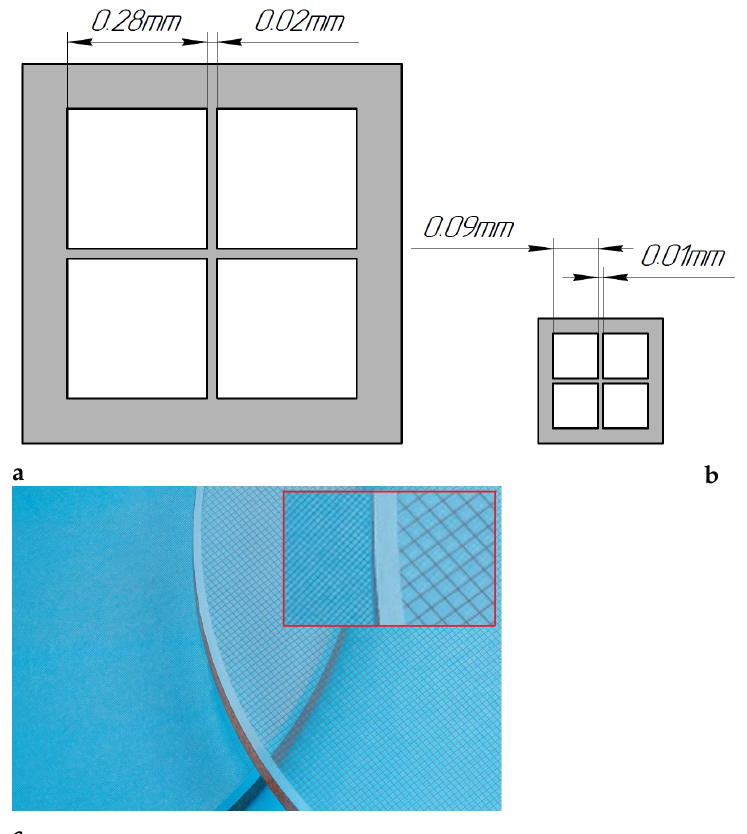
Figure 2. Sketches of the experimental samples 1 ( a ) and 2 ( b ), and macrophotography of the samples ( c